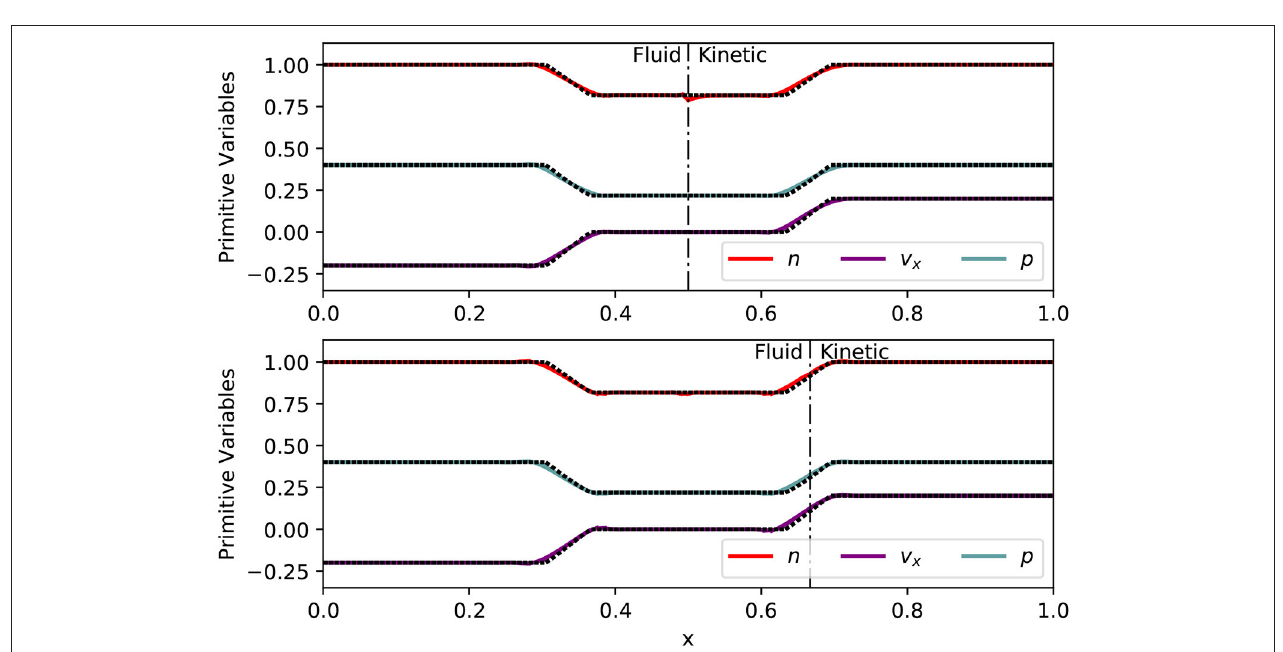
FIGURE 8 | Planar plasma switch density at t 2.5. Ballooning of the instability in the Mixed.25 case is significant. The adaptive case maintains most of the fine-scale = structure found in the Uniform two-fluid and Mixed.5 cases on the trailing edge, however the leading edge has noticeable differences.